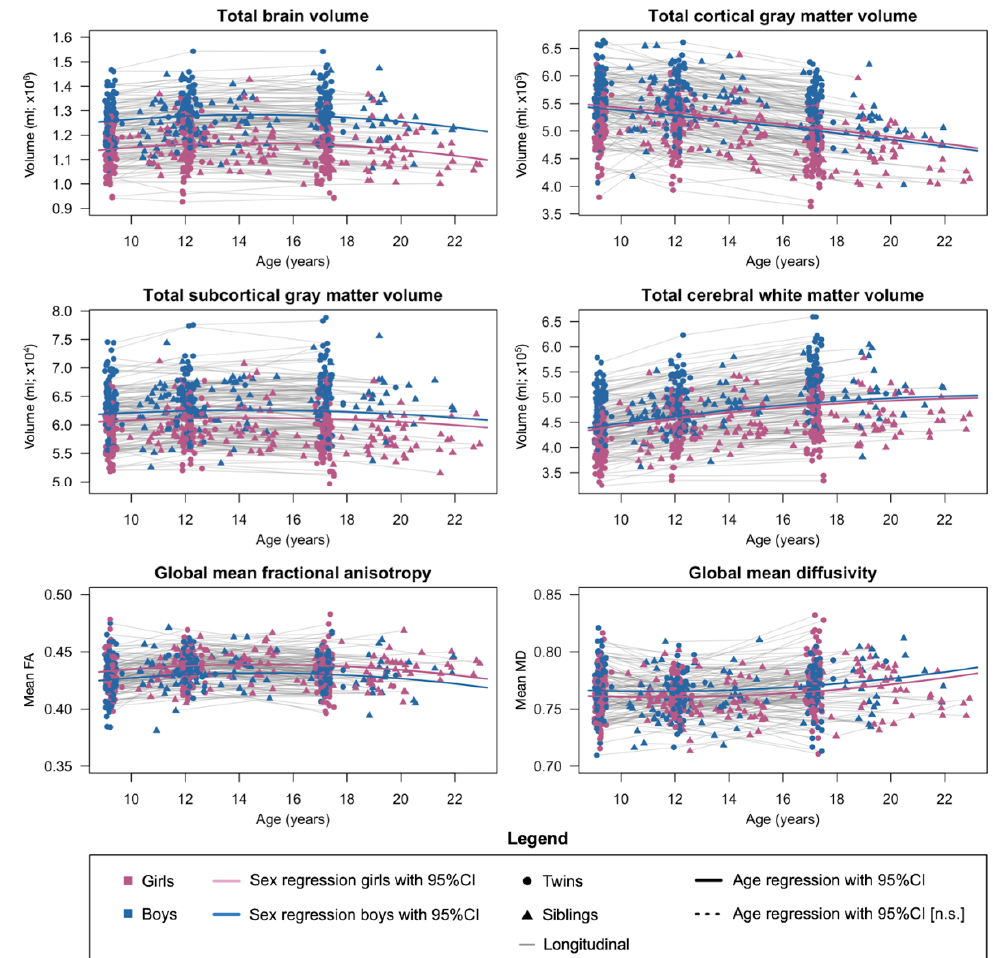
Figure 2. Development of global brain structures for boys and girls throughout adolescence. Sex effects for total (sub)cortical gray matter volume and cerebral white matter volume are plotted after simultaneous regression of total brain volume. The effect of sex was significant for all six global brain structures; the exact effect sizes and p -values of sex and age are reported in Supplementary Data File F2. Abbreviation (in alphabetical order): CI = confidence interval; n.s. = not significant.